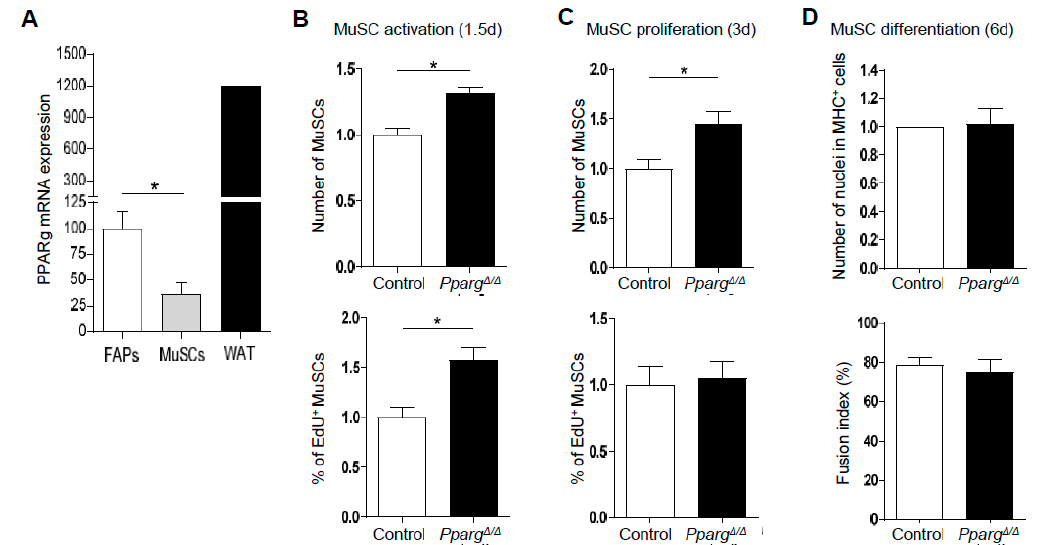
Figure 4. Pparg ∆ / ∆ MuSCs activate faster than control MuSCs ex vivo. ( A ) PPAR γ mRNA quantified by qPCR in freshly isolated MuSCs, FAPs and mouse white adipose tissue (WAT). n = 4 mice ( B , C ) Relative number (top panel) and percentage of EdU + (lower panel) MuSCs cultured for 36 h ( B ) or 72 h ( C ) after FACS isolation. ( D ) Myogenic differentiation of Pparg ∆ / ∆ and control MuSCs cultured for six days after FACS isolation. Relative quantification of the total number of nuclei having fused in MHC + myofibers is shown in the top panel, and fusion index (% nuclei in MHC + myofibers) is shown in the lower panel. ( B , D ) n ≥ 24 cell culture replicates pooled from at least three mice per genotype and replicated twice on different days. * p < 0.05; by Mann–Whitney test.